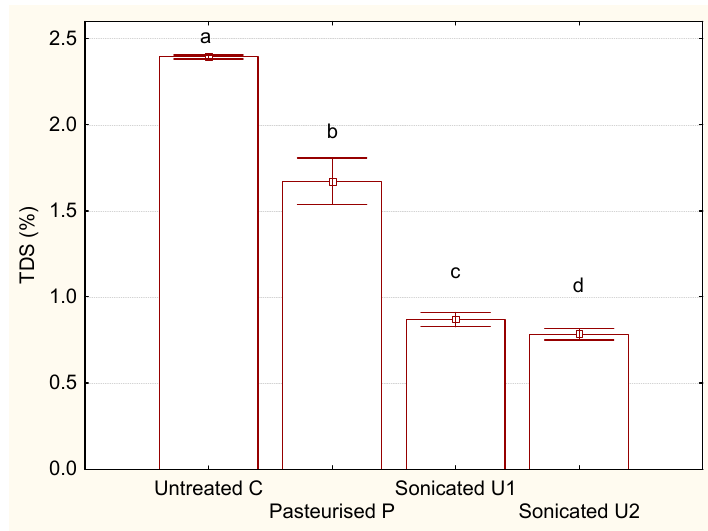
Figure 5. E ff ect of preservation method on solids content in apple juice. Error bars represent standard deviations. Values that share the same letter are not significantly di ff erent at P < 0.05.